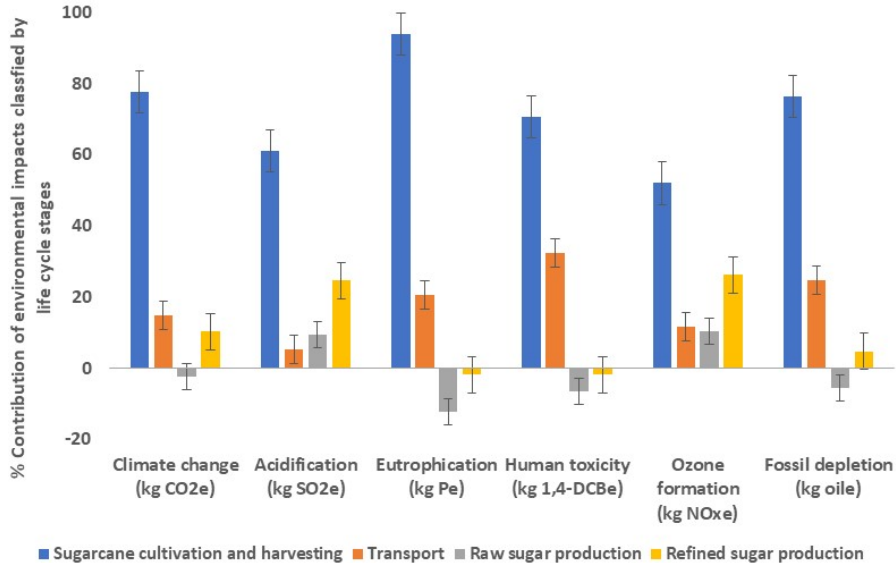
Figure 2. Environmental impact potentials of the sugar-electricity biorefinery system classified by life cycle stages.